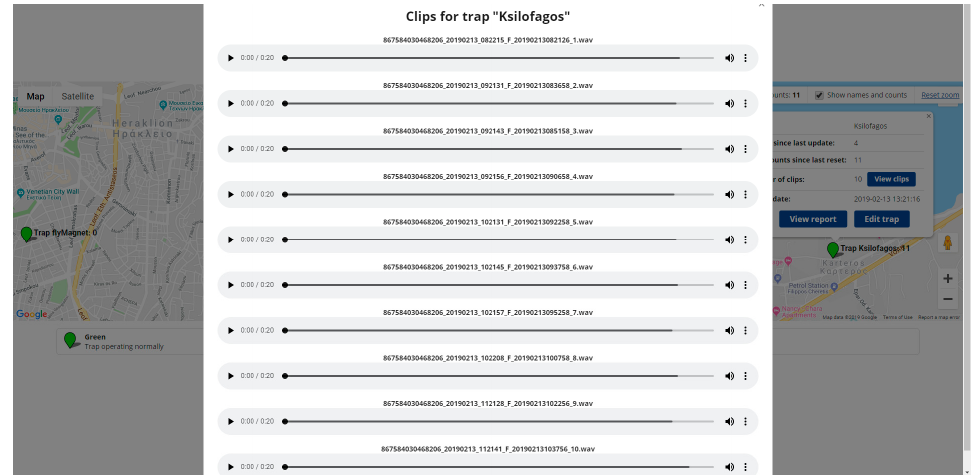
Figure 5. The reporting server manages recordings clips, tracks geospatial data, handles data inventorying and communication with all deployed sensors.